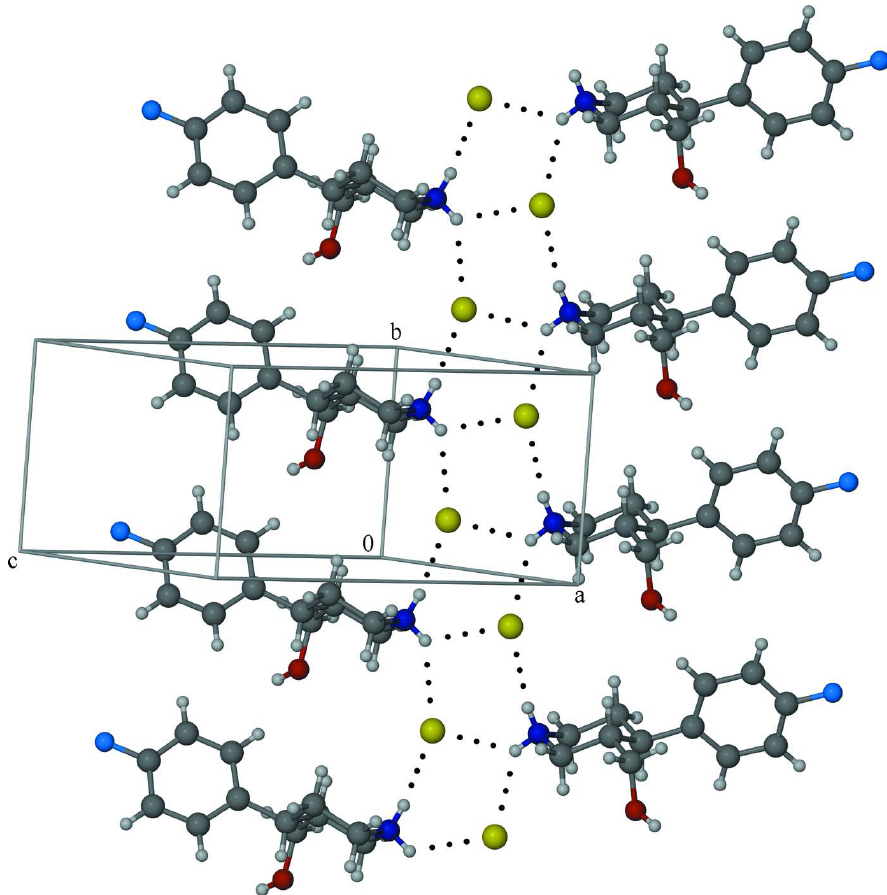
Figure 2 Crystal packing for (I). The molecular tape is sustained through the charge-assisted N + —H···Cl hydrogen bonds, shown as dashed